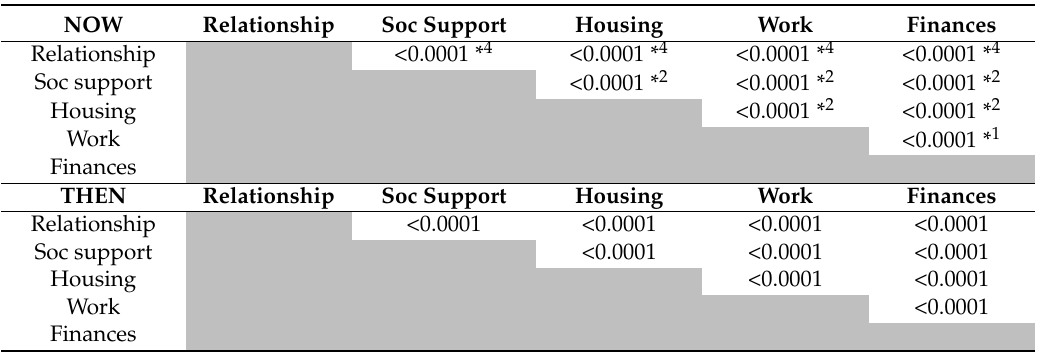
Table A5. Social/financial.